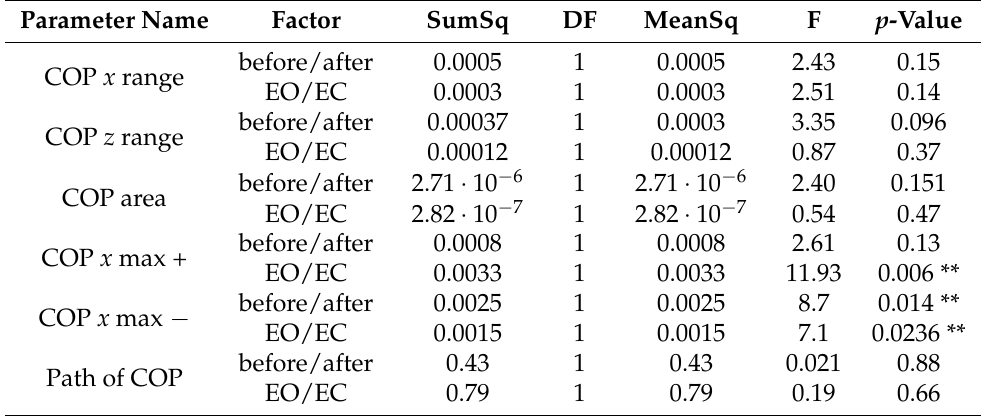
Table 4. Results of the ANOVA test for the COP parameters.